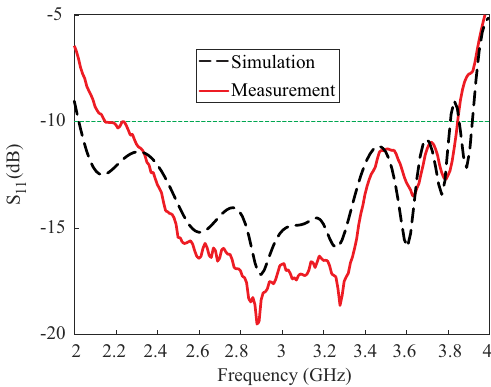
Figure 8. Measured and simulated reflection coefficients of the proposed